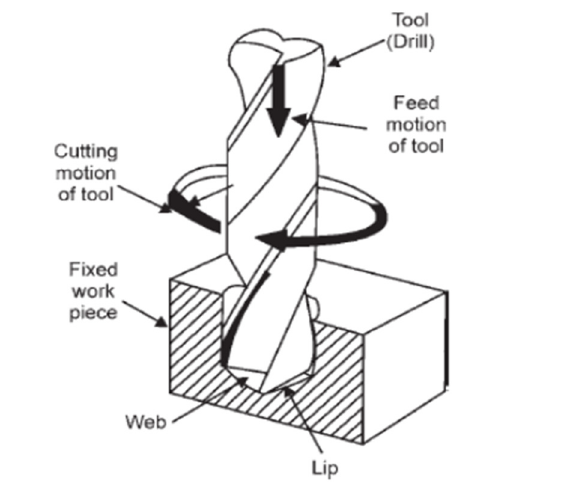
Fig. 1. Twist Drill Motion